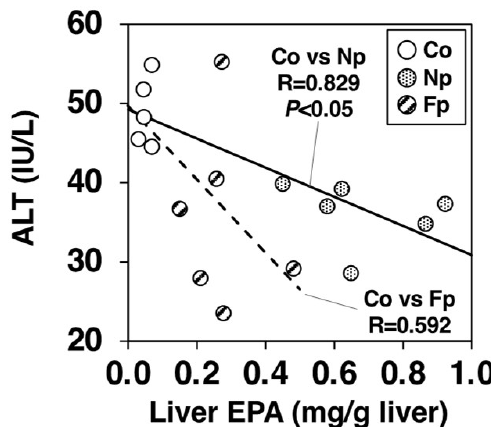
Figure 7. Correlations between hepatic injury marker levels (ALT activities) in the sera vs EPA levels in the livers of db / db mice. The mice were fed a basal diet (Co group), 10% NP-supplemented diet (Np group), or 10% FNP-supplemented diet (Fp group) for 4 weeks. Individual values are shown (n = 17). EPA: eicosapentaenoic acid, ALT: alanine aminotransferase.